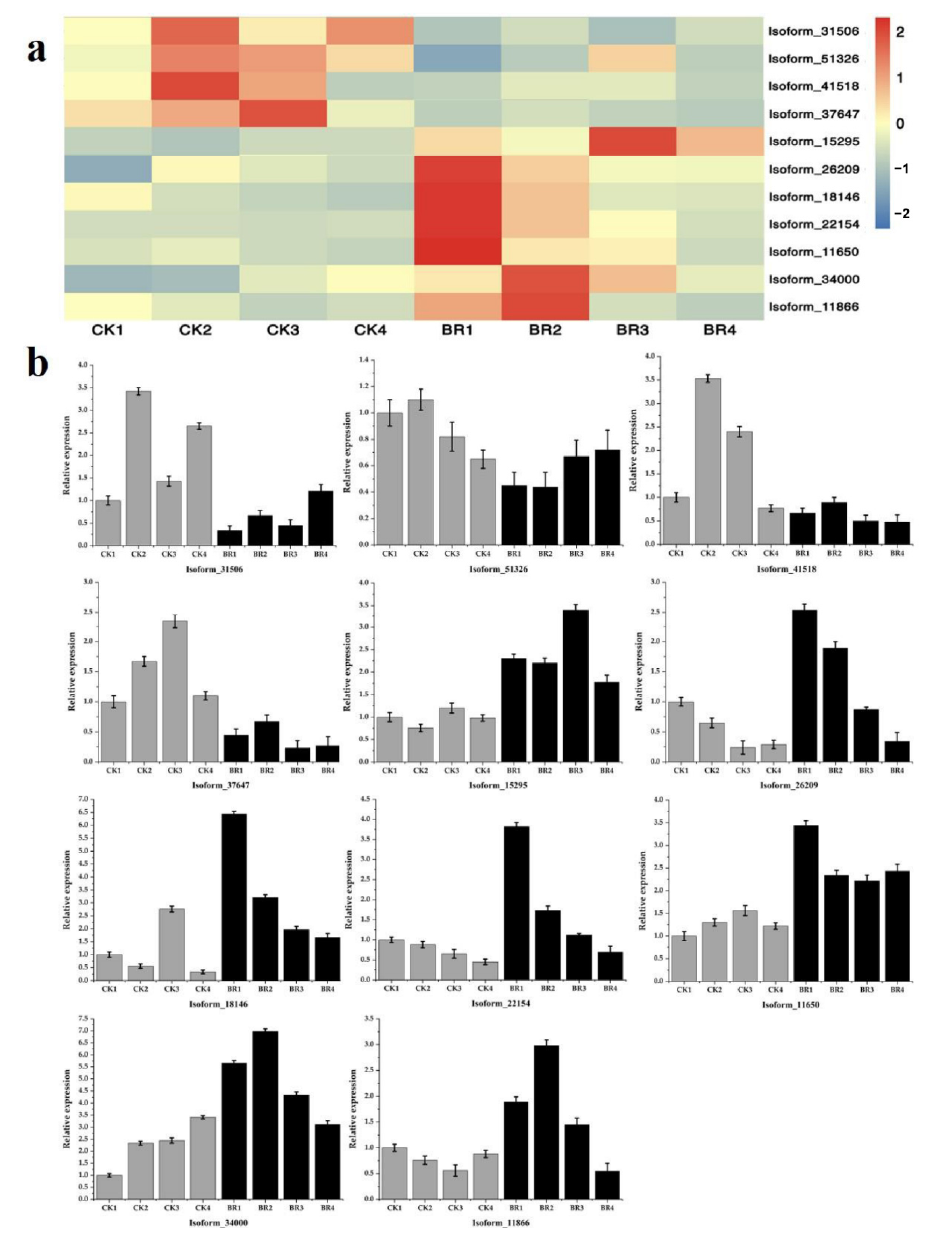
Figure 8. Validation of 11 isoforms using qRT-PCR. ( a ) Heatmap and relative expression levels of isoforms from transcriptome sequencing data; ( b ) qRT-PCR expression profile of isoforms.